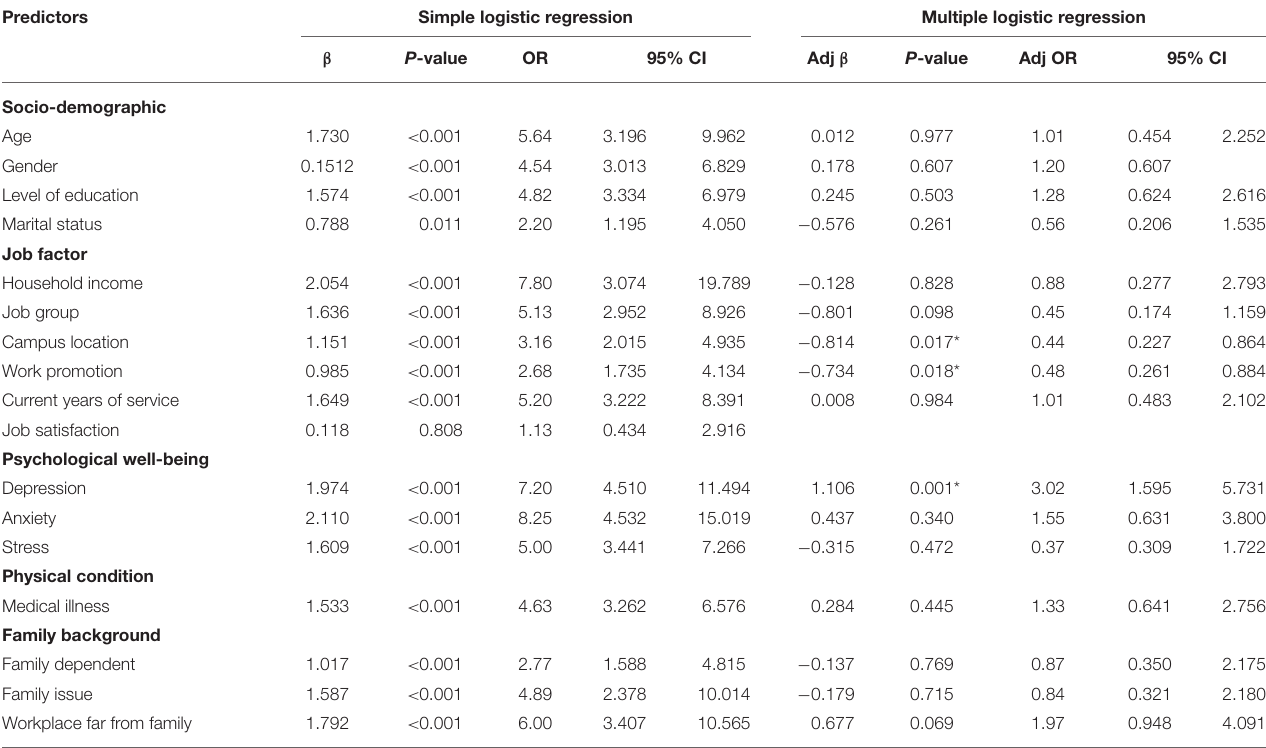
TABLE 4 | Logistic regression analyses for the predictors of WHOQOL-BREF SR-QOL domain. Predictors Simple logistic